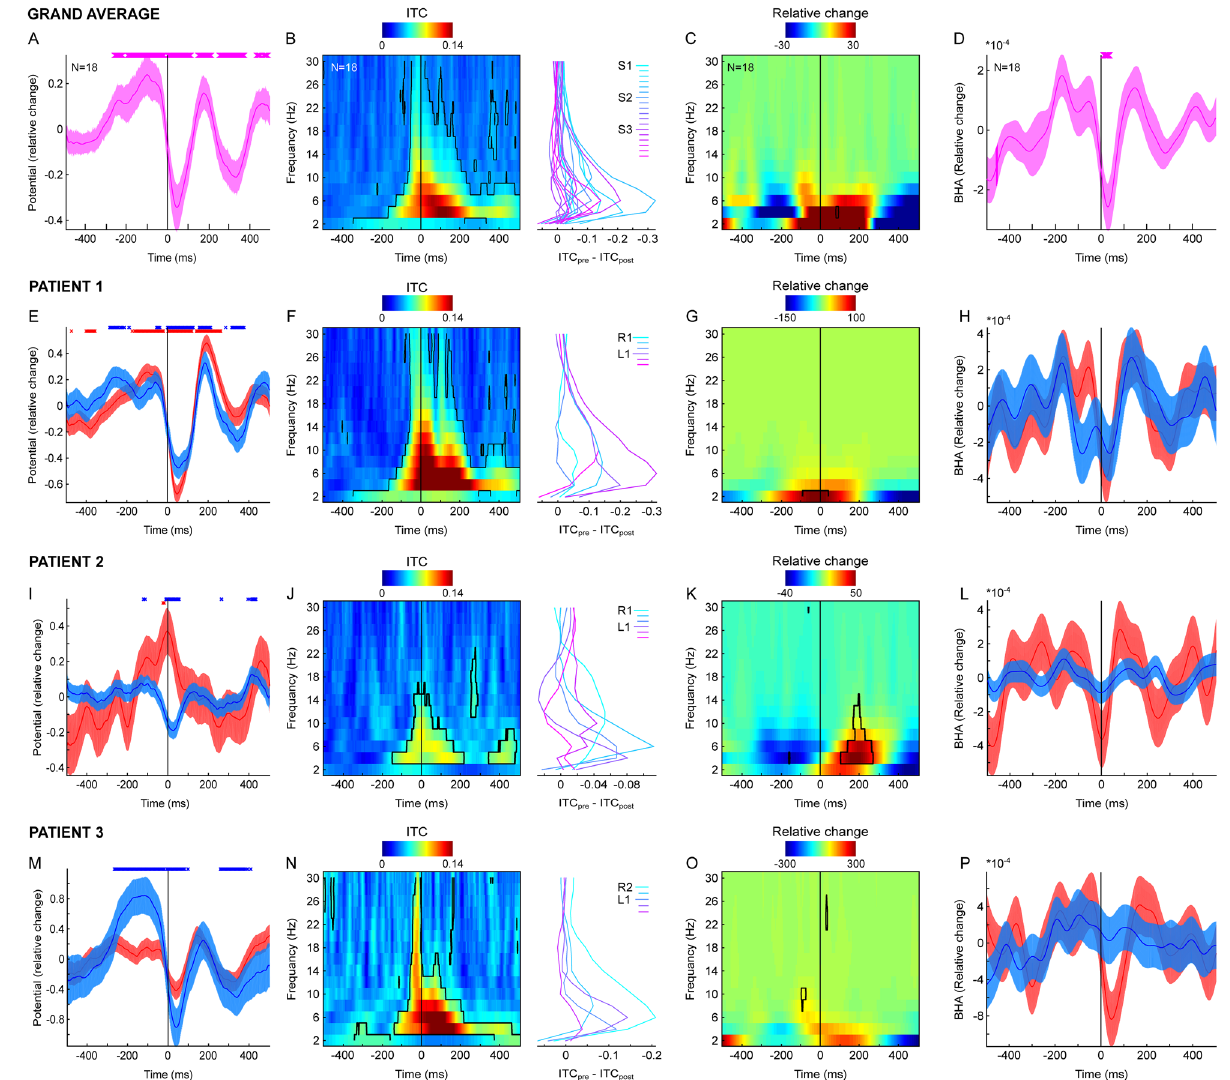
Figure 2. Fixation-locked neural activity in human ANT. ( A ) Grand average fixation-locked field potentials (N = 18 ANT channels, 3 patients). Vertical lines show the point of fixation onset. Markers above indicate significant time points ( p < 0.05; permutation test). ( B ) Color map shows ITC (time on x-axis, frequency on y-axis). Contours depict significant time–frequency points (permutation test p < 0.05). Vertical black line indicates fixation onset. Line plots on the right side indicate ITC change from pre- (− 300: − 100 ms) to post-fixation (0:100 ms) time window separately for each channel. ( C ) Color map shows fixation locked power relative to trial average (time on x-axis, frequency on y-axis). Contours present change from surrogate distribution (permutation test p < 0.05). ( D ) Fixation-locked BHA (80–180 Hz). Vertical black line indicates fixation onset. Markers above indicate significant time points (permutation test p < 0.05). ( E ) Fixation-locked field potentials (patient 1) from channels on the right ANT (blue) and left ANT (red). Vertical black lines show the point of fixation onset. Markers above indicate significant time points (permutation test p < 0.05). ( F ) Same as B but for data from patient 1. ( G ) Same as C but for data from patient 1. ( H ) Fixation-locked BHA (patient 1) from channels on the right ANT (blue) and left ANT (red). Vertical black lines show the point of fixation onset. Data from patient 2 ( I – L ) and patient 3 ( M – P ) plotted with the same convention as ( E – H ). Note that the reversed polarity in patient 2 left channels might be explained by a more posterior and dorsal trajectory of the left electrode shaft. Furthermore, patient 3 had the right side electrode placed deep with ventral channels showing no signal (note only R2 and R3 are presented; see “Methods” section for more details). All results are controlled for multiple comparisons with Benjamini and Hochberg/Yekutieli false discovery rate procedure. Shading reflects standard error of the mean